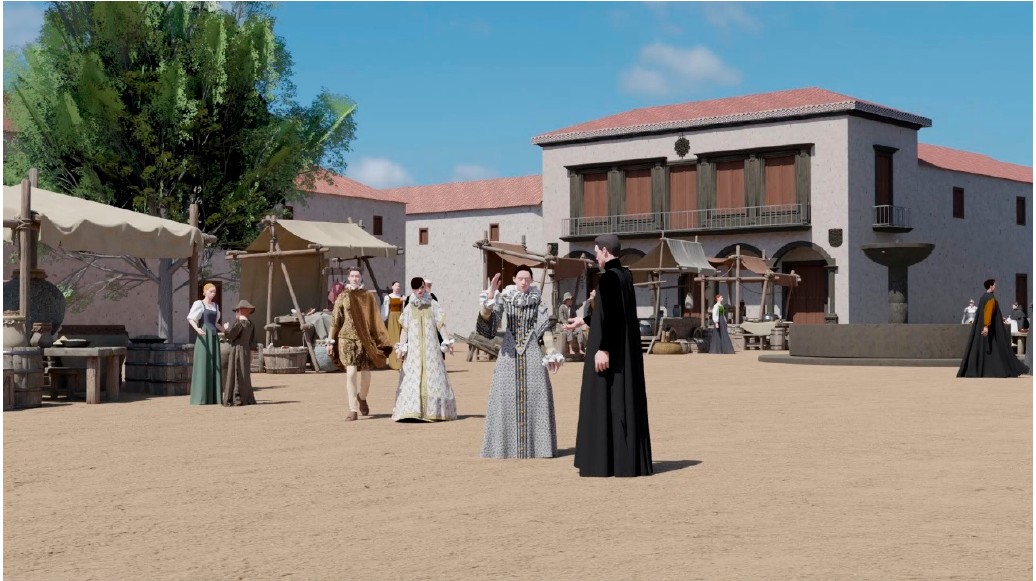
Figure 26. A recreation of San Miguel de los Ángeles square (also named Adelantado).